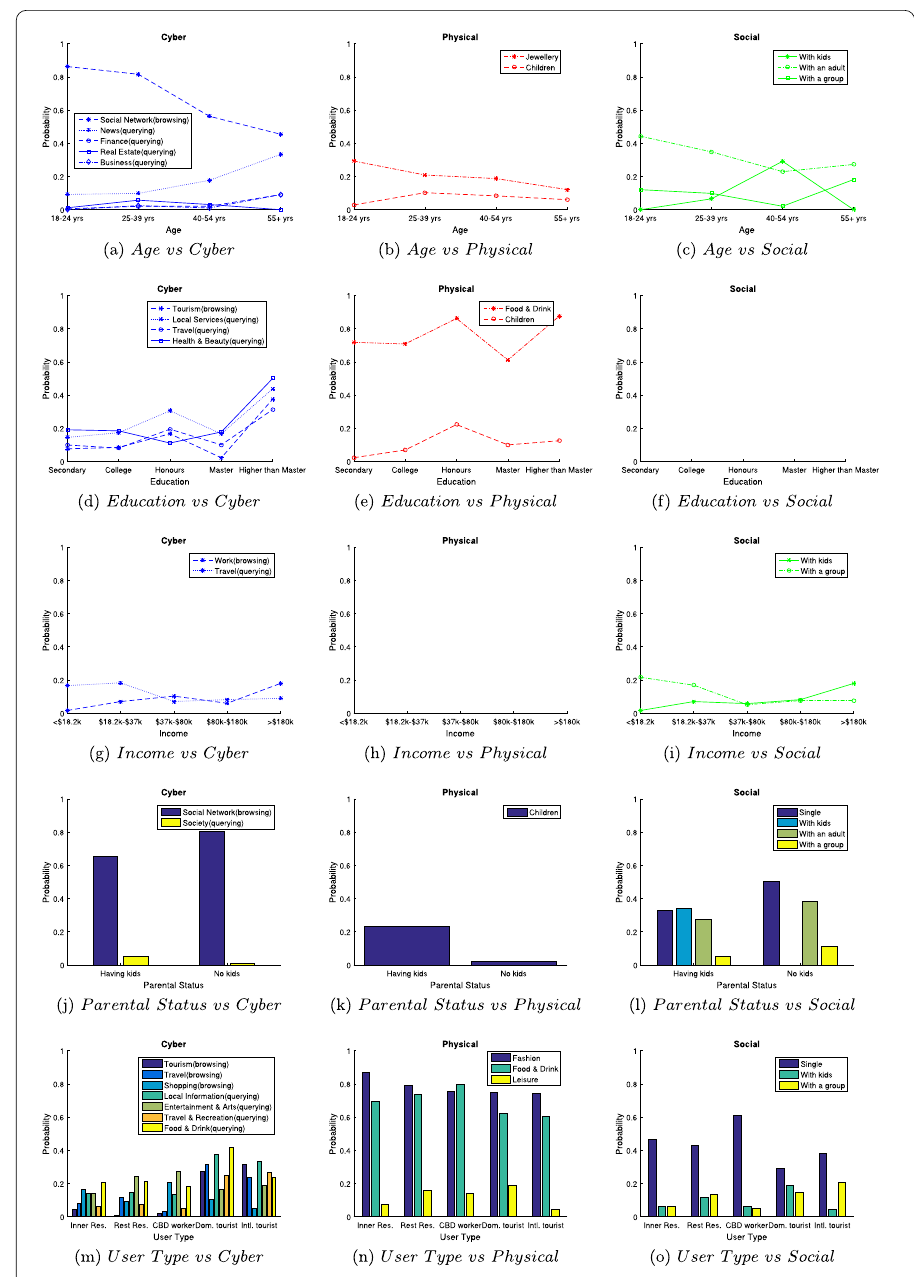
Figure 2 Significant associations of demographic attributes with CPS categories ( χ 2